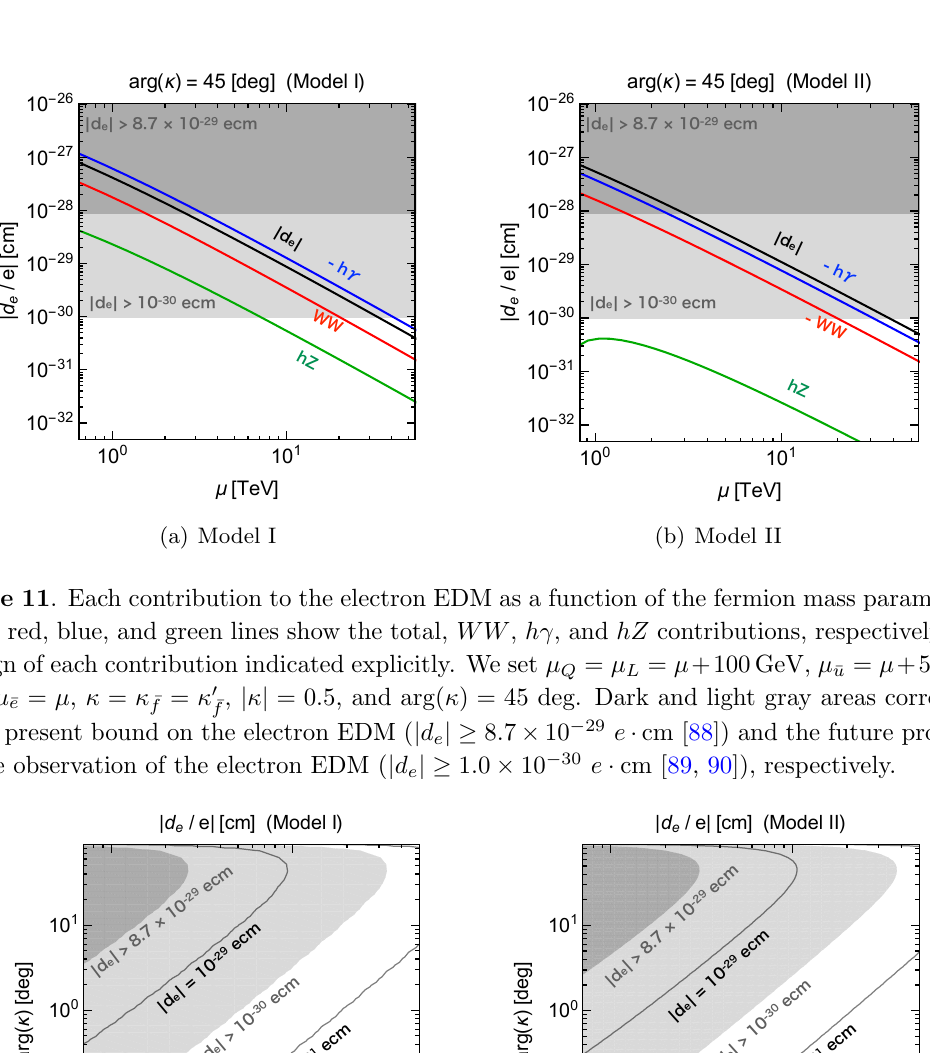
Figure 12 . Contour plots for the electron EDM. We take the same parameters as in (cid:12)gure 11 except for arg( (cid:20) ). Dark and light gray areas correspond to the present bound on the electron EDM ( 8 : 7 10 (cid:0) 29 e cm [88]) and the future prospects for the observation of the electron EDM d e j j (cid:21) (cid:2) (cid:1) ( 1 : 0 10 (cid:0) 30 e cm [89, 90]), d e j j (cid:21) (cid:2) (cid:1)